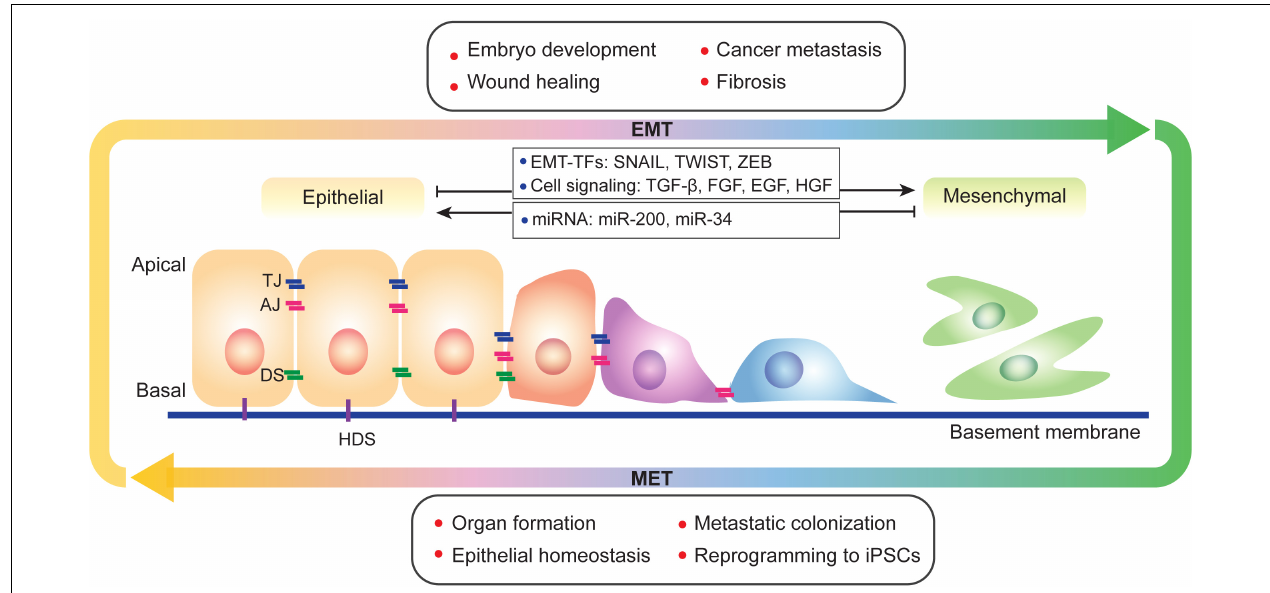
FIGURE 1 | A brief view of EMT and MET. EMT and its reverse process MET occur during physiological and pathological progresses and display a spectral characteristic. During EMT, epithelial cells lost its apical-basal polarity and connections between cells and basement membrane. EMT is regulated by multiple factors, such as transcription factors, cell signaling and epigenetic modification. TJ, tight junction; AJ, adherens junction; DS, desmosome; and HDS,